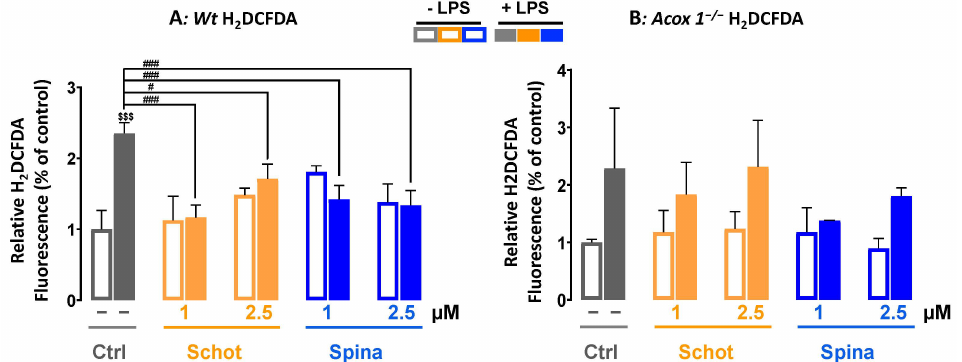
Figure 2. Effects of Schot and Spina on ROS production induced by LPS in the Wt ( A ) and Acox1 − / − ( B ) BV-2 microglial cells assessed by the H 2 DCFDA (5 µ M) dye test. Cells were incubated for 7 h with Schot or Spina (1 or 2.5 µ M) in the absence or presence of LPS (1 µ g/mL). All values are presented as means ± SD of two independent experiments performed in triplicate, with the statistical significance of the increase in mean signal indicated as ### p ≤ 0.01 and # p ≤ 0.05 compared to LPS and $$$ p ≤ 0.001 compared to the different treatments with or without LPS administration. Statistical significance was determined using two-way ANOVA followed by Tukey’s test for multiple